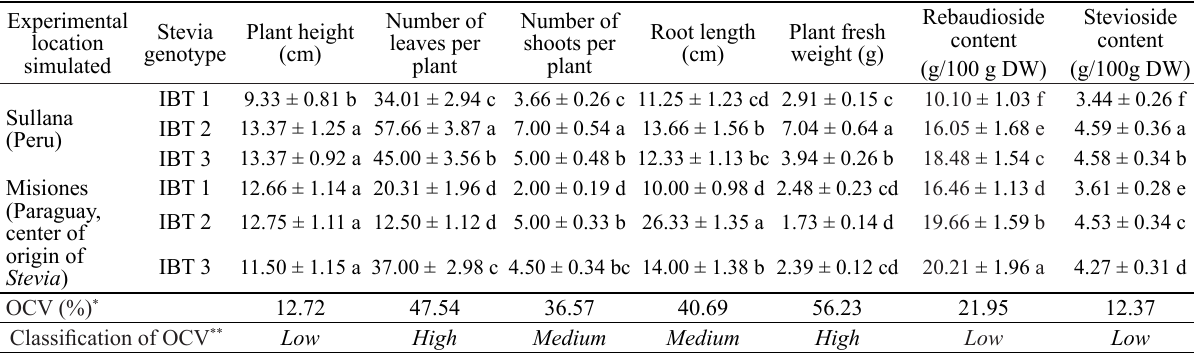
Table 2 . Phenotypes of Stevia materials in two contrasting environmental conditions simulated under controlled conditions (averages ± SE).